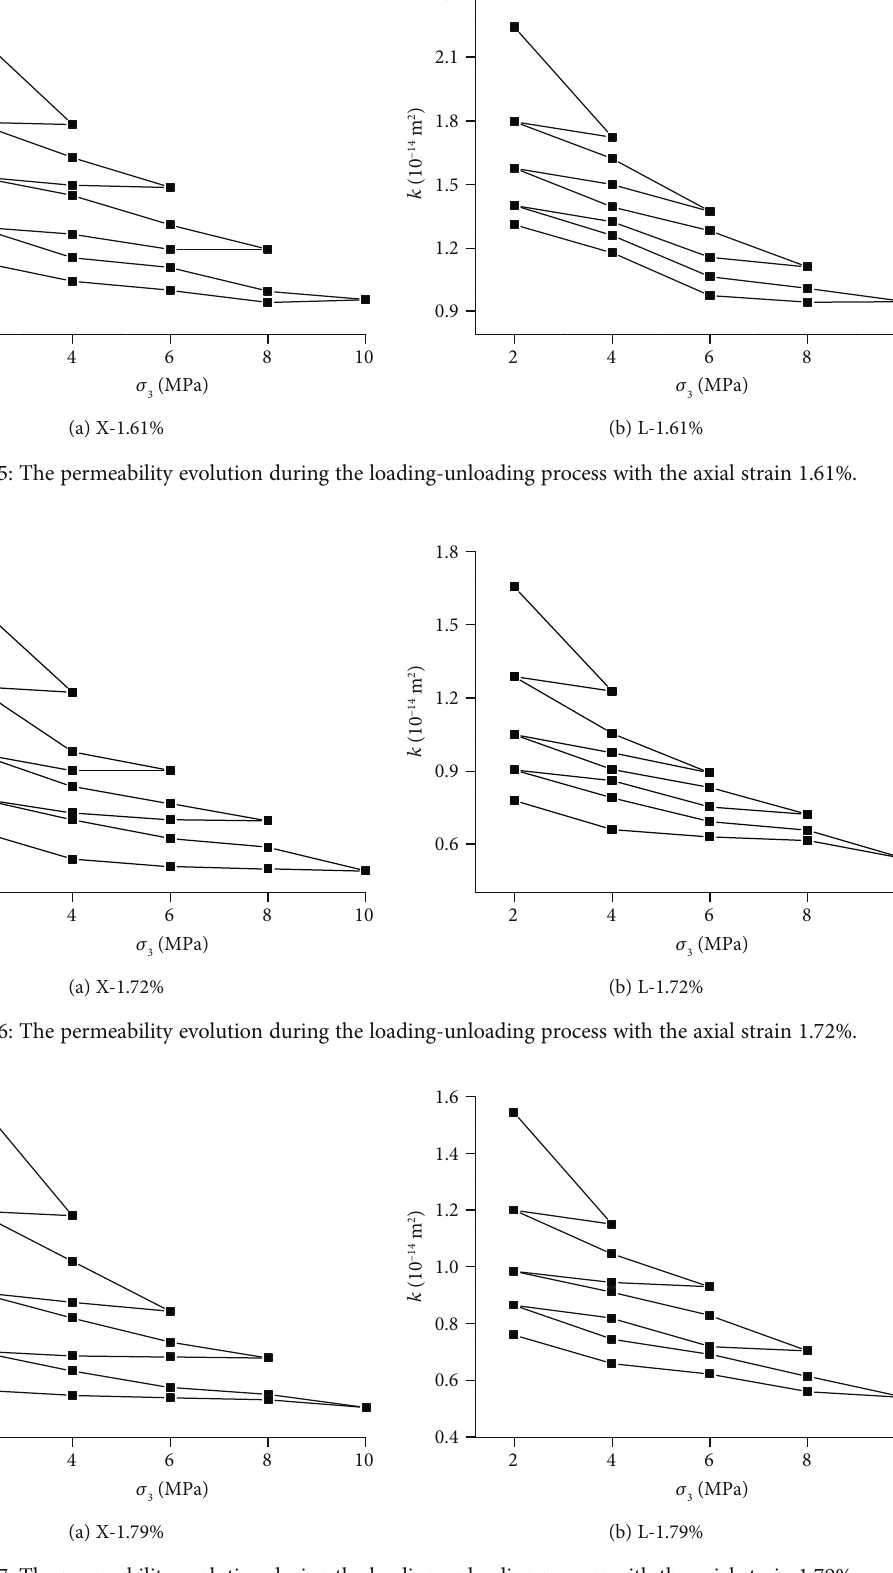
Figure 17: The permeability evolution during the loading-unloading process with the axial strain